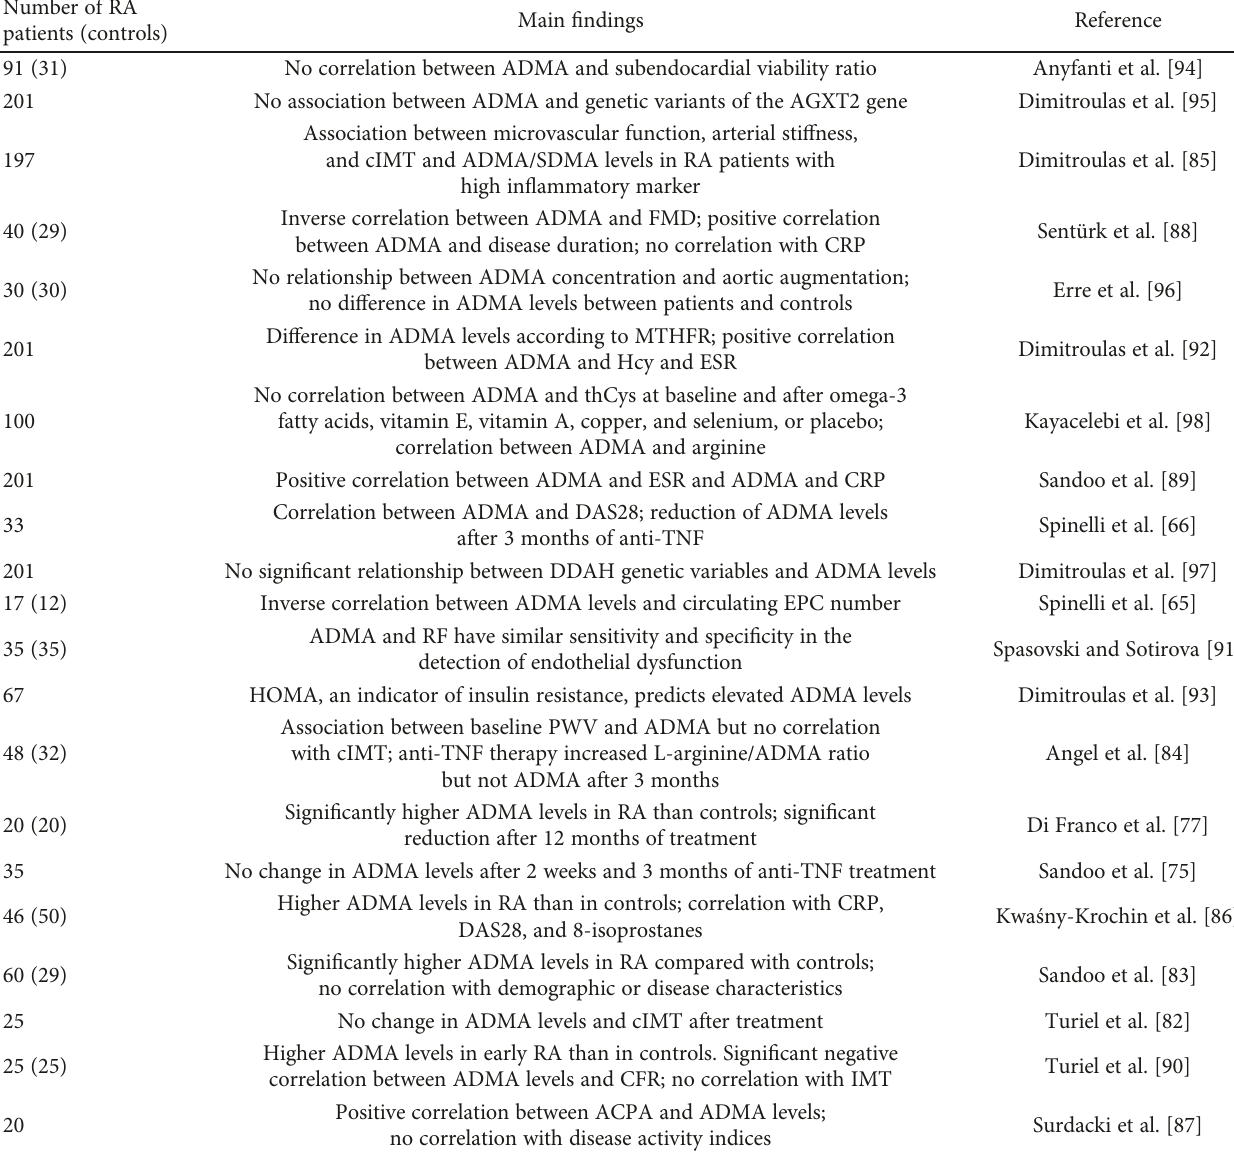
Table 1: Main fi ndings of the studies investigating ADMA in rheumatoid